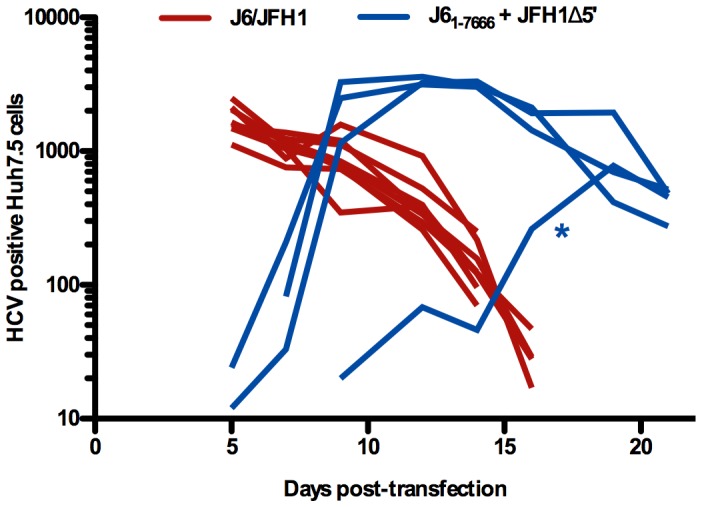
Emergence of positive recombinants in frequency experiment.Cells were transfected and 18 hours later distributed into 96-well format (7000 cells plated per well) to study recombination frequency. The number of HCV positive cells per well of replica staining plates plated ever 2–3 days (as indicated in Materials & Methods) was followed over time and is shown for the 8 J6/JFH1 positive controls and the 4/72 wells co-transfected with J61–7666 and JFH1Δ5′, where recombinants emerged. Contamination of these four cultures by J6/JFH1 was excluded by passaging of virus to naïve cells and sequencing the NS2/NS3 junction, except for one recombinant (*) that was too attenuated to efficiently re-infect naïve cells. Cell numbers below 10, corresponding to background, are not plotted. Decline in number of infected cells correlated with massive virus induced cell death.